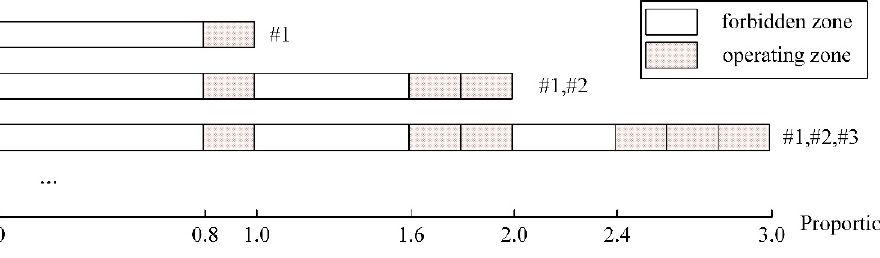
Figure 3. Illustration of the operating zones calculation.